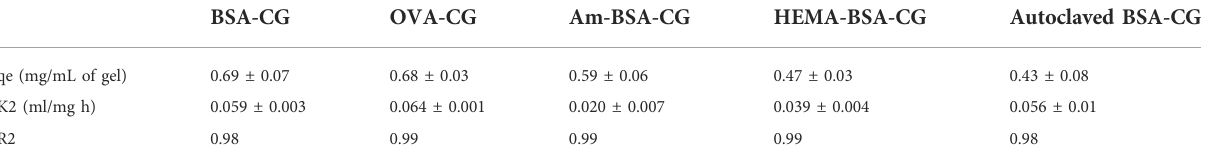
TABLE 4 Pseudo-second-order parameters for the adsorption of haemin on albumin-based cryogels.